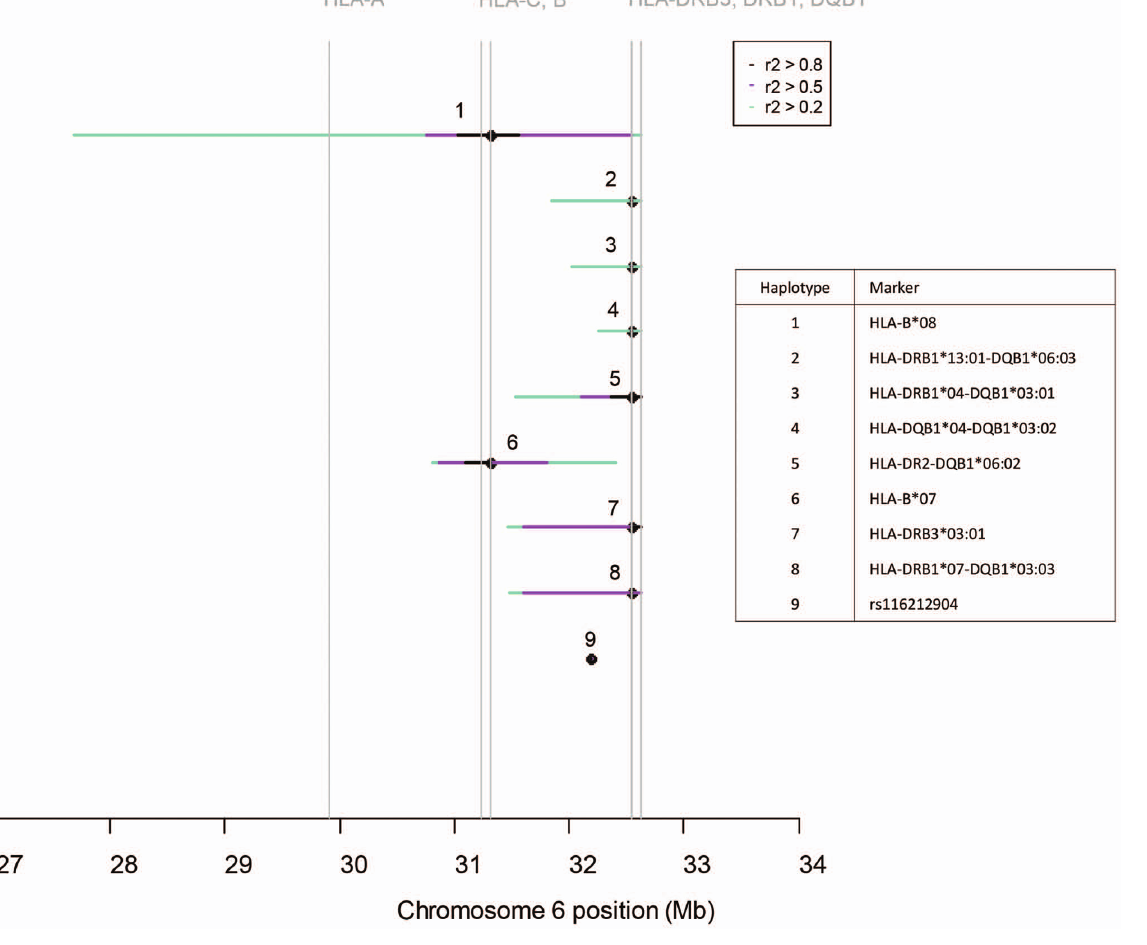
Fig. 3. The extension of nine significantly primary sclerosing cholangitis (PSC) associated major histocompatibility complex (MHC) haplotypes, observed in the unconditional and conditional regression analyses combined. The extension of the haplotypes is determined by three categories of linkage disequilibrium ( r 2 . 0.2 (green), r 2 . 0.5 (purple) and r 2 . 0.8 (black), respectively) between a single haplotype marker (listed in the figure box) and any single nucleotide polymorphism (SNP) in the dataset. Haplotype 1; AH8.1